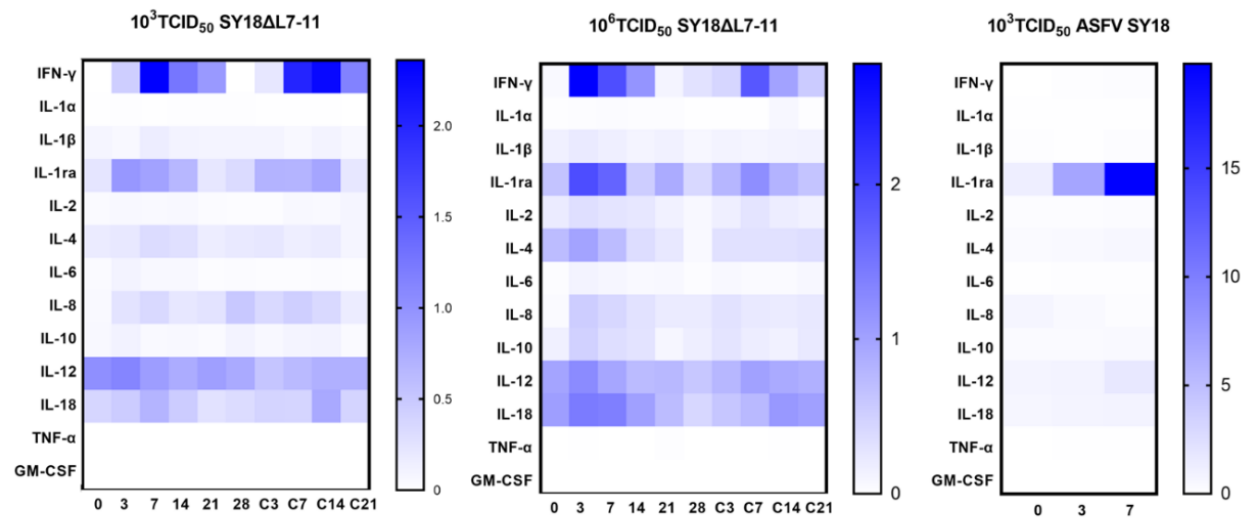
Figure 6. Assessment of cytokines in pigs inoculated i.m. with 10 3 or 10 6 TCID 50 SY18 △ L7-11 and 10 3 TCID 50 ASFV SY18. Animals inoculated with SY18 △ L7-11 were challenged with 10 3 TCID 50 ASFV SY18 at 28 dpi. The heatmap was drawn using the median of each group.